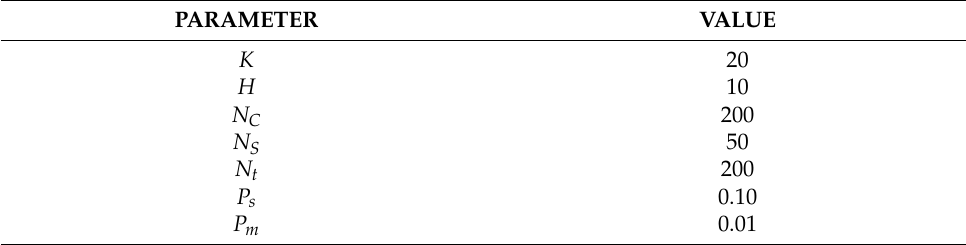
Table 1. Experimental